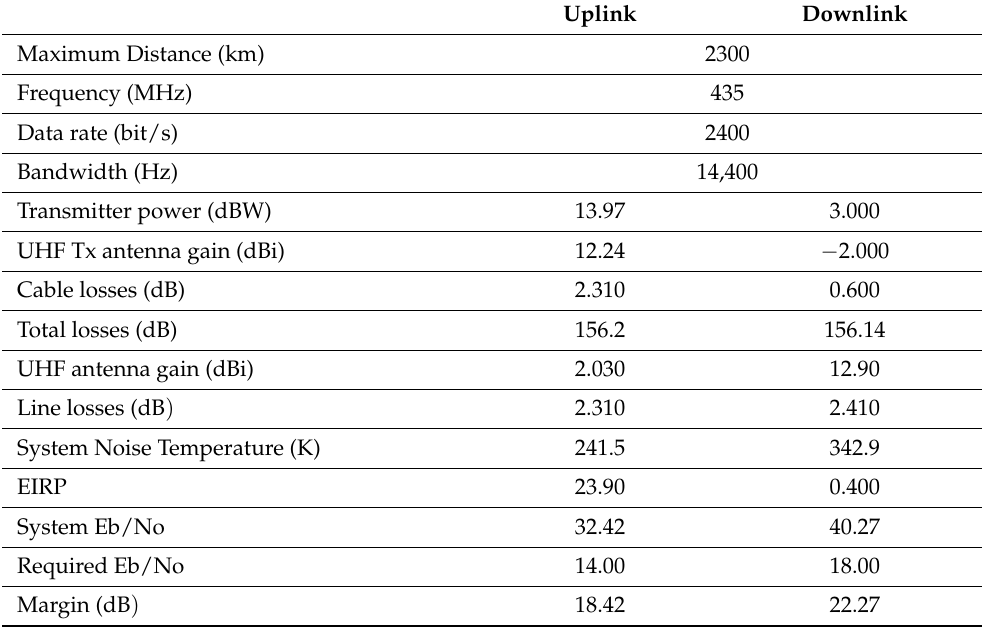
Table 6. Light-1 UHF link budget.